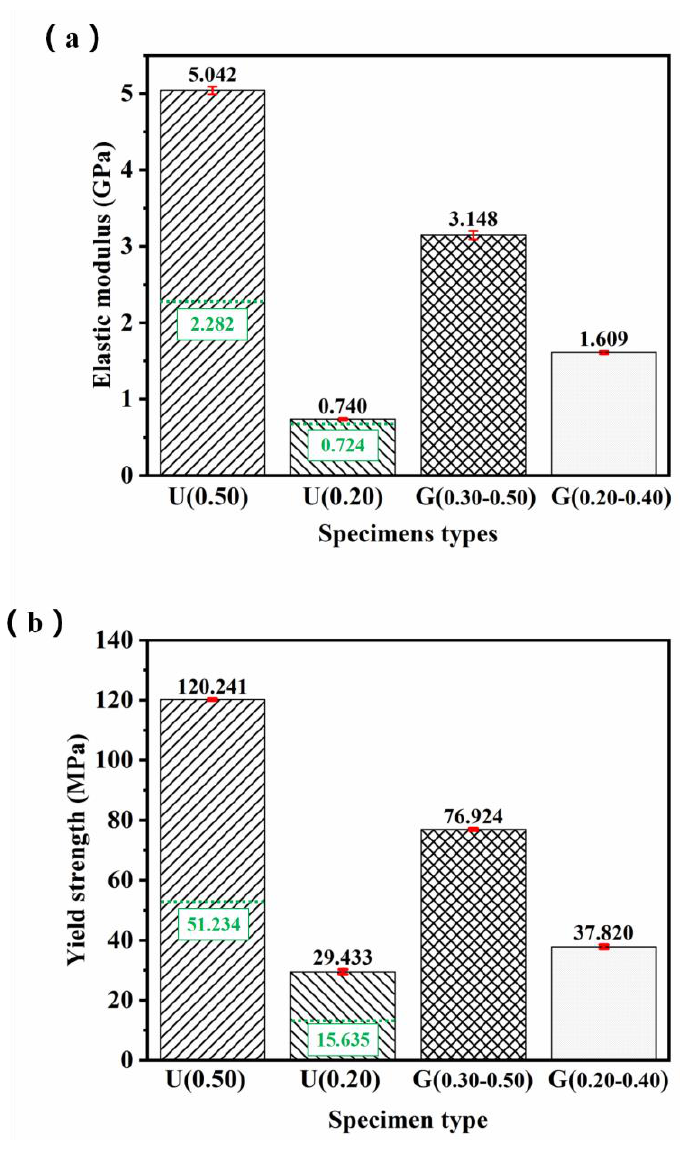
Figure 8. ( a ) The elastic modulus and ( b ) yield strength of lattice structures. The green datas are from reference